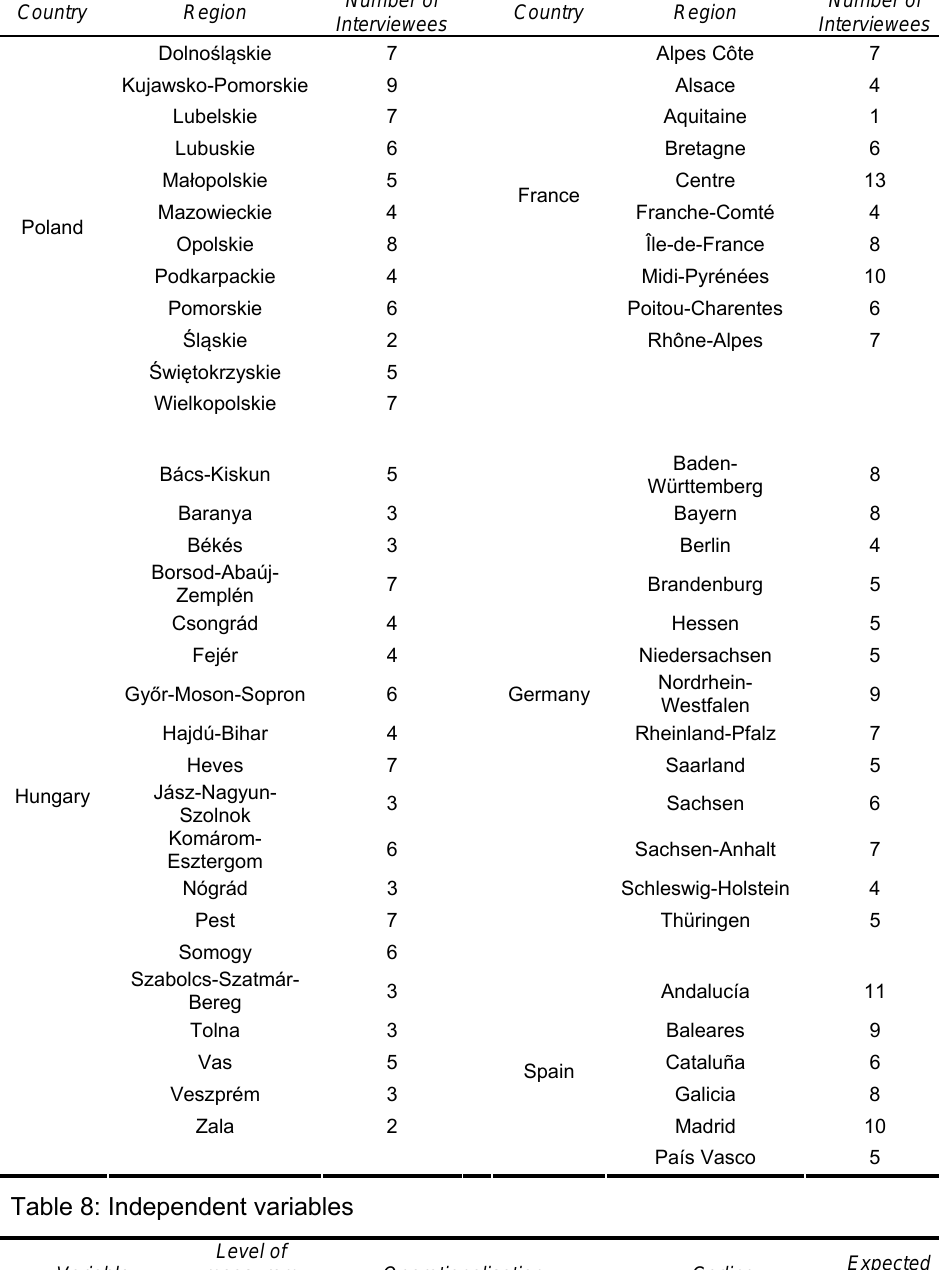
Table 7: Overview of regions represented in the sample Country